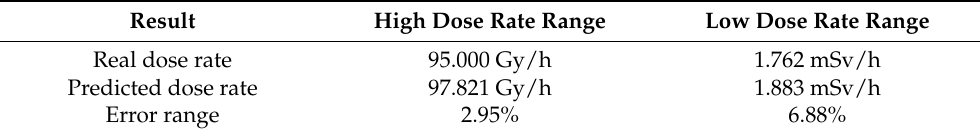
Table 7. Calibration error analysis.